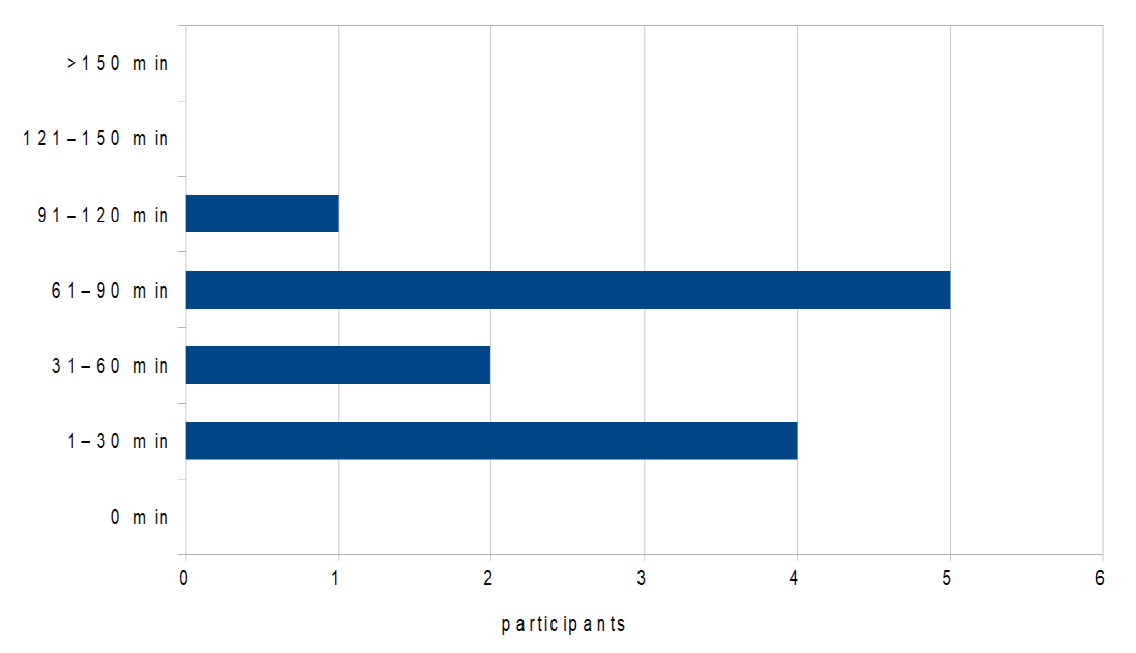
Figure 6. Evaluation of the data within a single choice to the following question: “How much time did you invest in the preparation and follow-up of patient consultations in which you were asked to lead the conversation?”.